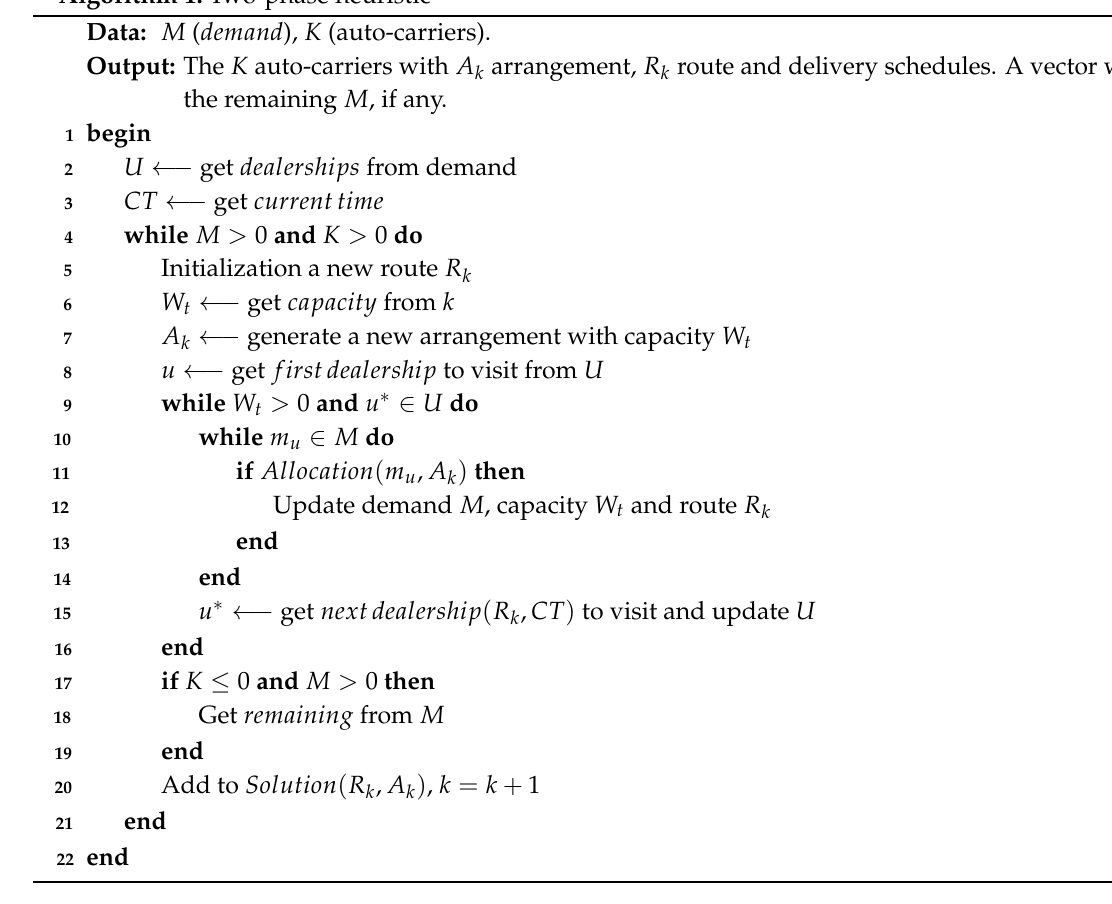
Algorithm 1: Two-phase